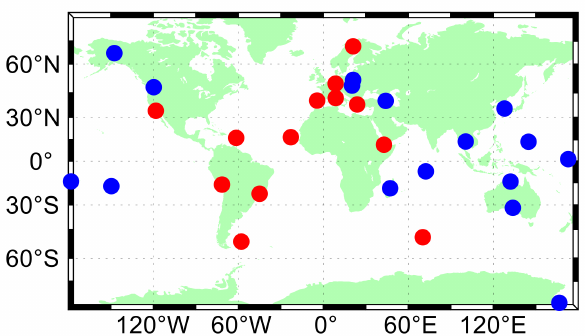
Figure 9. Geographical distribution of 29 selected MGEX stations. The stations marked in both red and blue can track the GPS, GLONASS, Galileo, BDS-2 and BDS-3 satellites, and only the stations marked in blue can track the QZSS